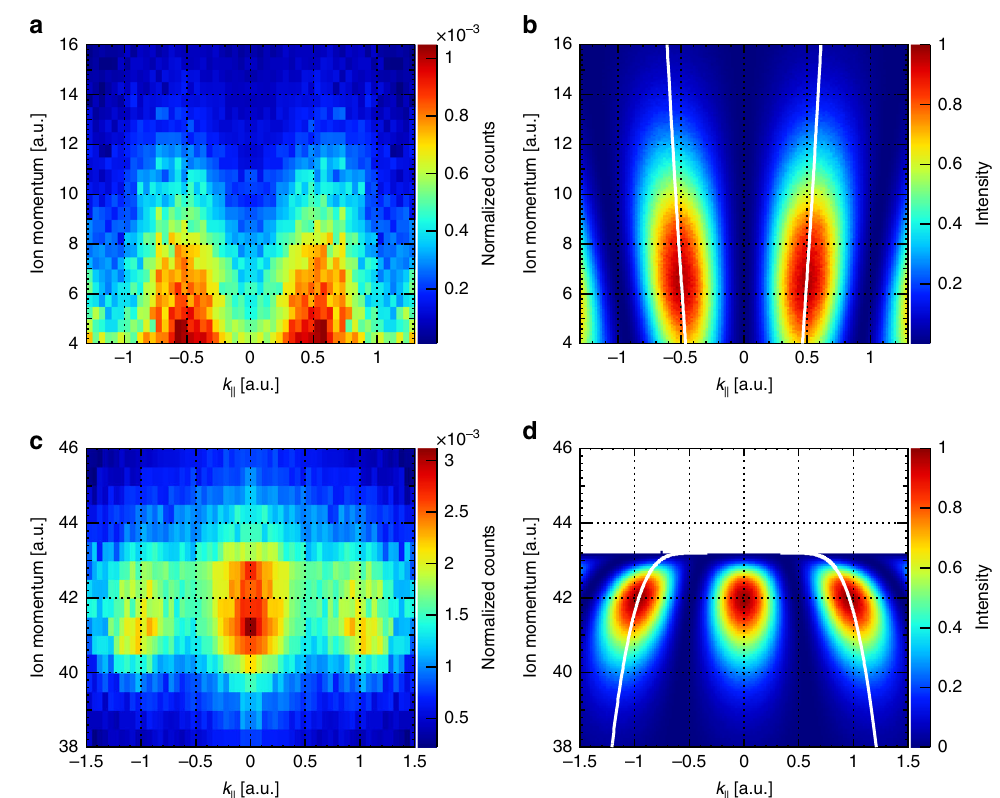
Fig. 4 Dependence of the two-center electron interference on the internuclear distance. The internuclear distance is encoded in the momentum of the ion. a , c – experimental distributions for the linearly polarized light (symmetrized with respect to the k ║ = 0 line) for direct and indirect dissociation pathways, respectively; b , d classical simulations using the II(1/2) g and I(1/2) u potential energy curves, respectively (Fig. 1). Each row in a , c was divided by the spectrum of the monomer in order to remove the ionization weighting. For the eye guidance, the white lines on the simulated distributions show dependence of the fringe position on the ion momentum. The dimer axis was selected to lie within ±15° to the fi eld polarization direction. k ║ is the electron momentum component parallel to the dimer axis